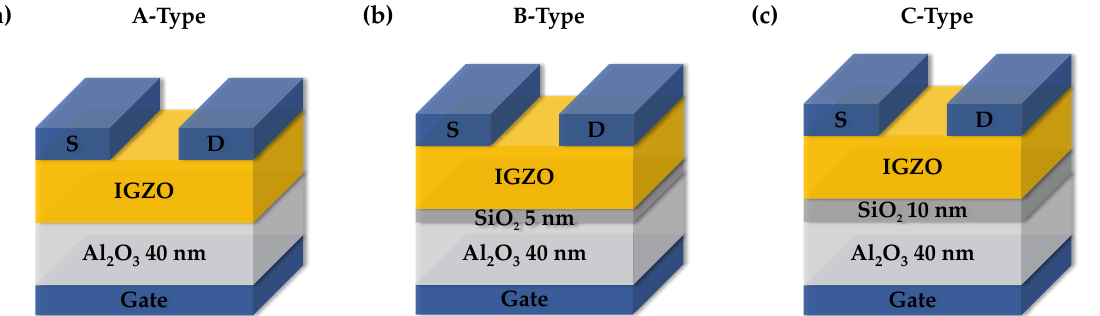
Figure 1. Schematic view of three-type bottom gate IGZO TFTs. ( a ) LT ALD-deposited 40 nm Al 2 O 3 (A-type), ( b ) LT ALD 40 nm Al 2 O 3 /e-beam 5 nm SiO 2 (B-type) and ( c ) 10 nm SiO 2 (C-type).